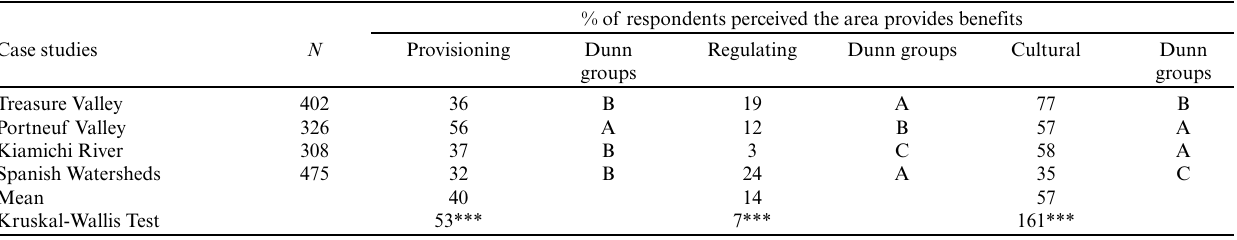
Table 3. Percentage of respondents that provided examples of ecosystem services grouped by categories (i.e., provisioning, regulating, and cultural) (*** indicate statistical significance at the 0.01